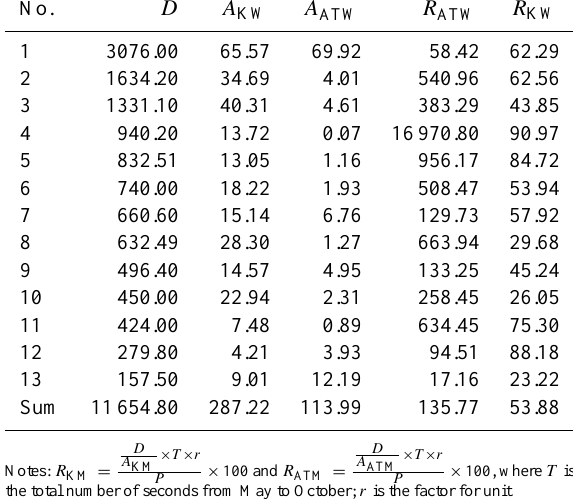
Table 4. Infiltration efficiency from the atmospheric precipitation in the upstream catchment area of subsurface runoffs (or karst springs). No. is the number of subsurface runoff or karst spring, and D is its discharge (Ls − 1 ). A kw represents “upstream accumu- lation area of subsurface runoff (or karst spring) in karst watersheds (KW, km 2 ) ” and A ATW represents “upstream accumulation area of subsurface runoff (or karst spring) in auto-delineating topographic watersheds (ATW, km 2 ) ”. R ATW (%) is the percentage of precipita- tion into subsurface runoff in ATW and R KW (%) is the percentage of precipitation into subsurface runoff in KW.